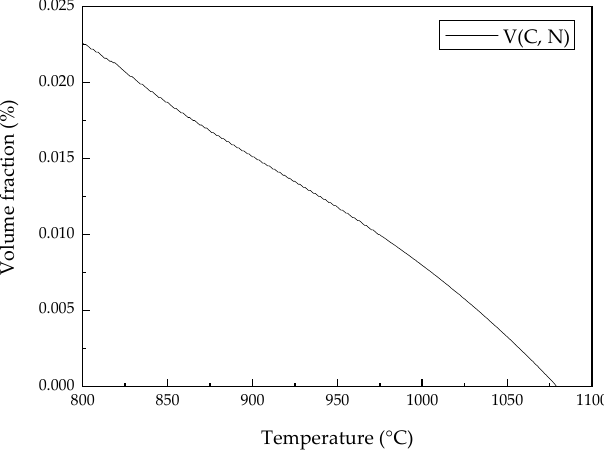
Figure 15. Volume fraction variation of V(C, N) in 10 V steel with